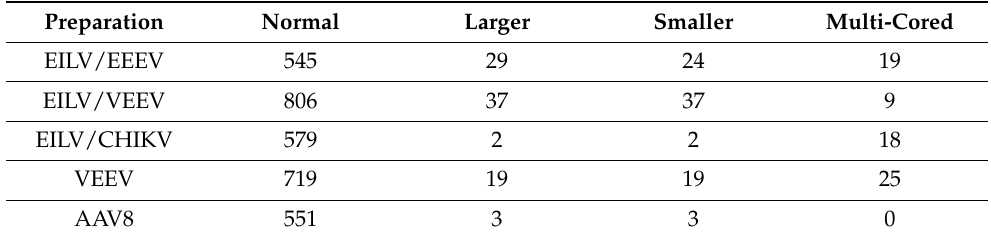
Table 1. Distribution of particle morphologies in cryo-electron micrographs of four alphaviruses and one parvovirus (adeno-associated virus serotype 8, a non-pleomorphic icosahedral virus): this table shows the number of viral particles counted with each morphology. Preparation Normal Larger Smaller